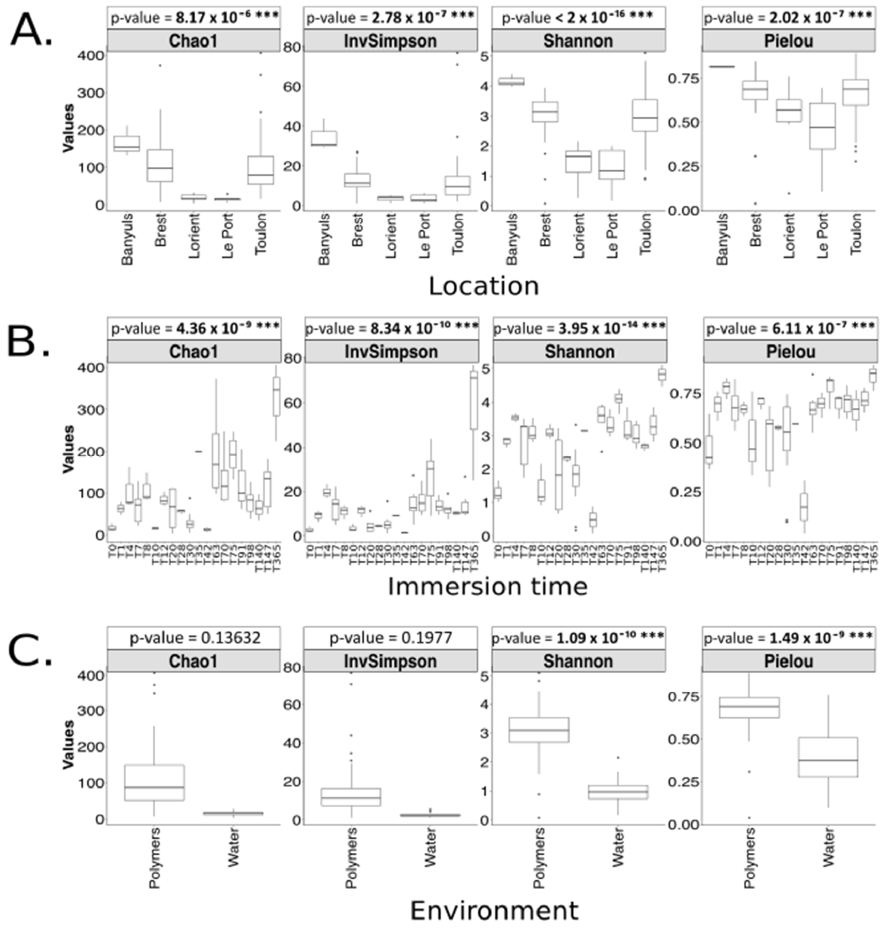
Figure 2. Alpha diversity indices and their associated significance, based on the ITS2 dataset for the variables ( A ) “Location”, ( B ) “Immersion time” (days), and ( C ) “Environment”. “***” represents a very highly signi fi cant in fl uence of the evaluated factor.